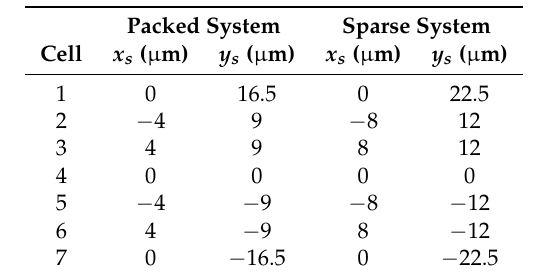
Table 1. Cells Cartesian coordinates.